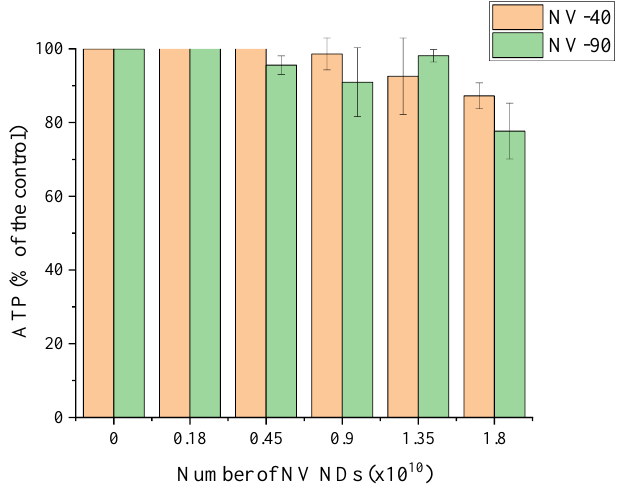
Figure 5. The effect of NV NDs on ATP production in MSCs. Cells were seeded at a density of 2 × 10 5 cells/well for 24 h and NDs were then incubated with MSCs for a further 24 h ahead of measuring ATP.